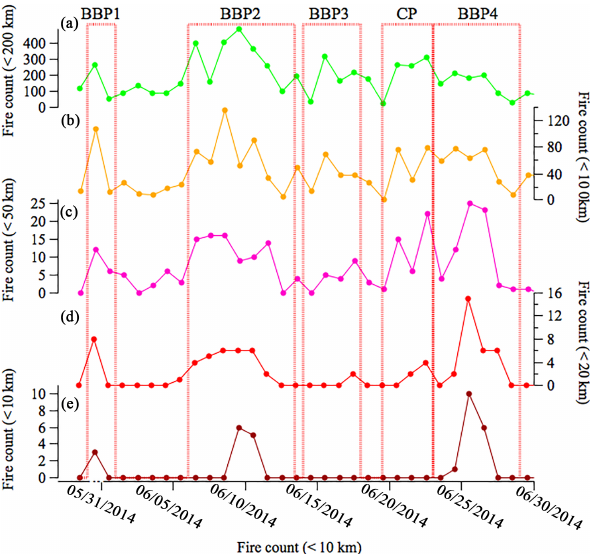
Figure 2. The number of hotspots observed each day within (a) 200km, (b) 100km, (c) 50km, (d) 20km and (e) 10km of ATARS, as detected by the MODIS and VIIRS sensors on the Terra and Aqua satellites.